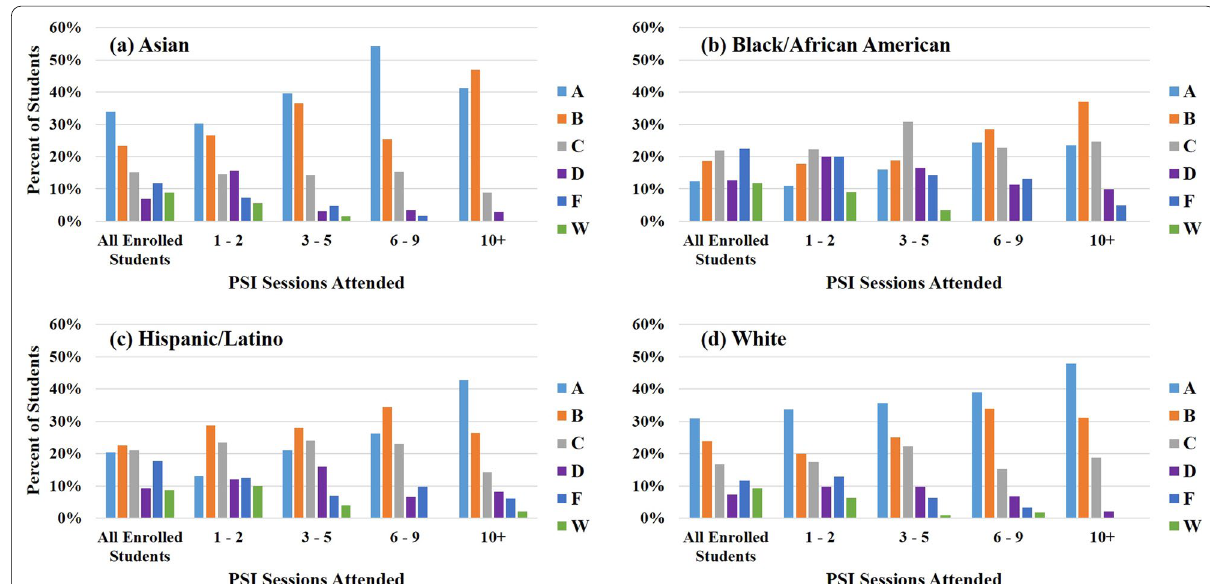
Fig. 3 Final course grade distributions of PSI participants, grouped by session attendance, for students identifying as a Asian ( N African American ( N 679), c Hispanic/Latino ( N = students enrolled in PSI courses for students identifying as a Asian ( N and d White ( N =